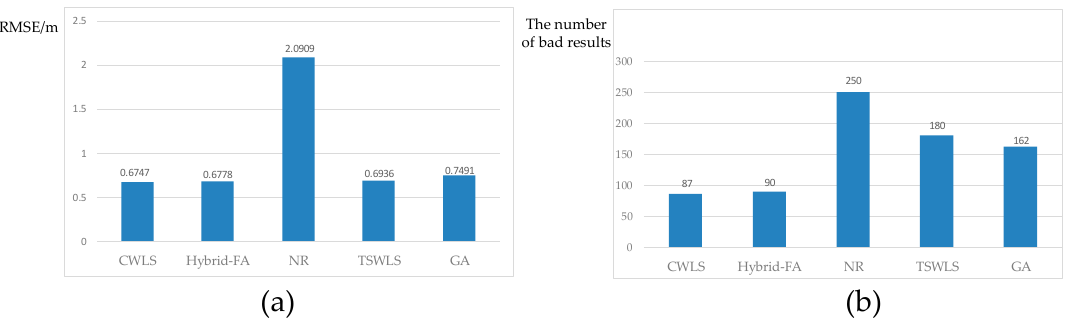
Figure 7. The results of the first experiment. ( a ) The RMSE of the five methods. ( b ) The number of bad results from the five methods.